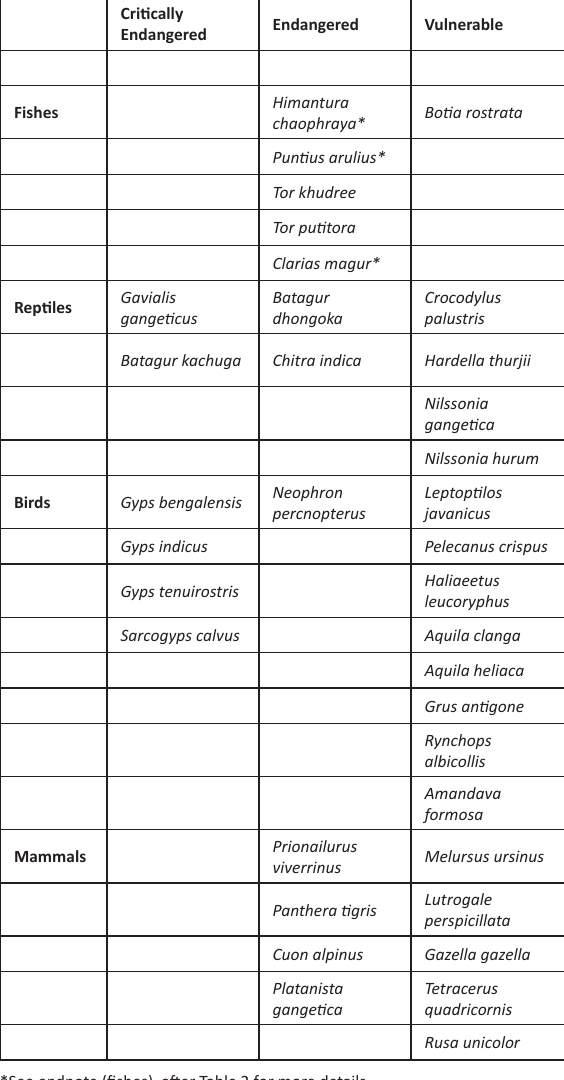
*See endnote (fishes), after Table 2 for more